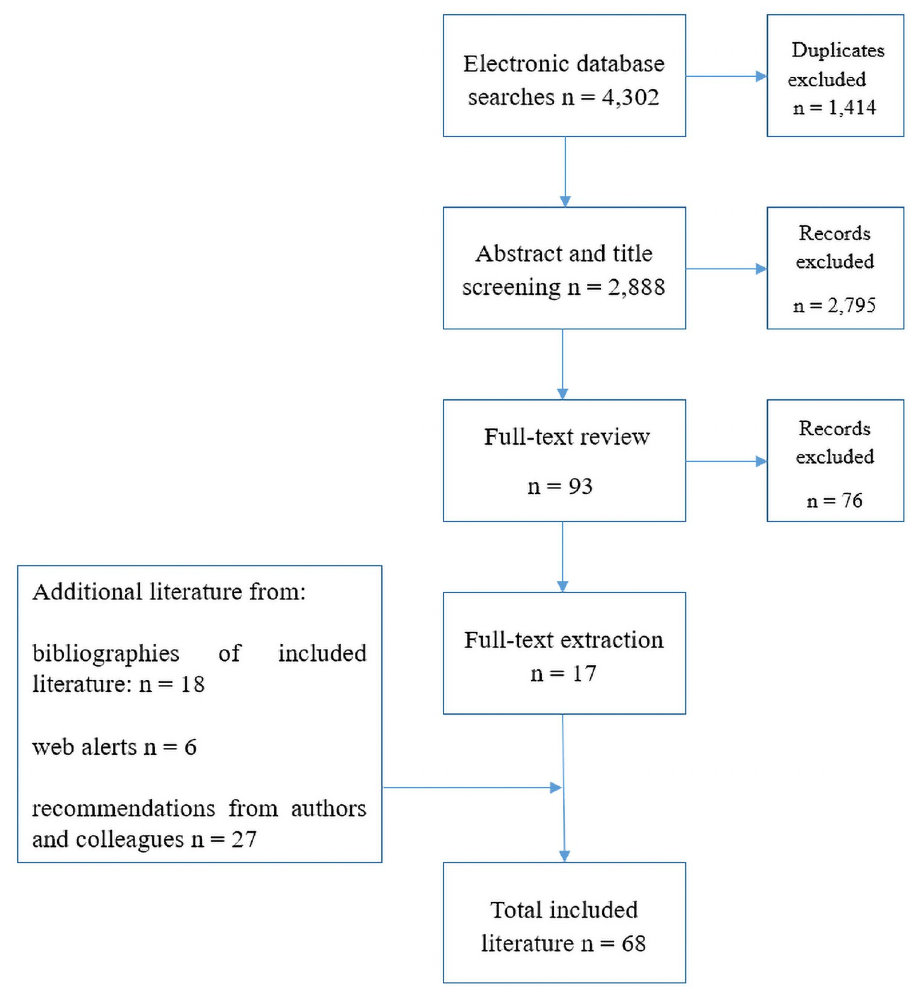
Fig 1. Study selection